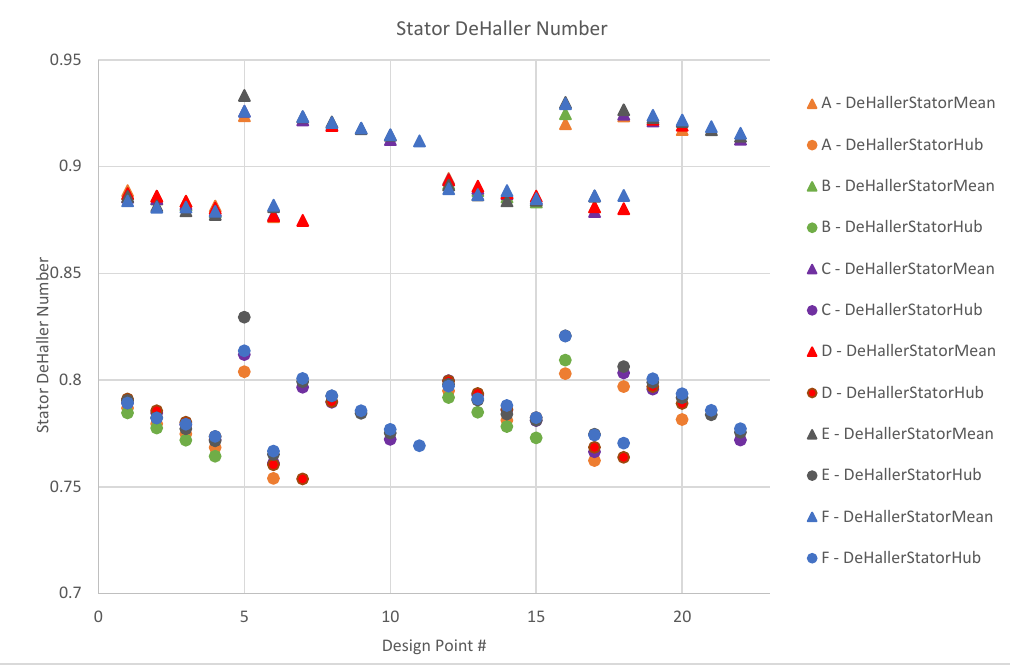
Figure 21. Variations in the stator DeHaller factor with the different stator blade parameters.